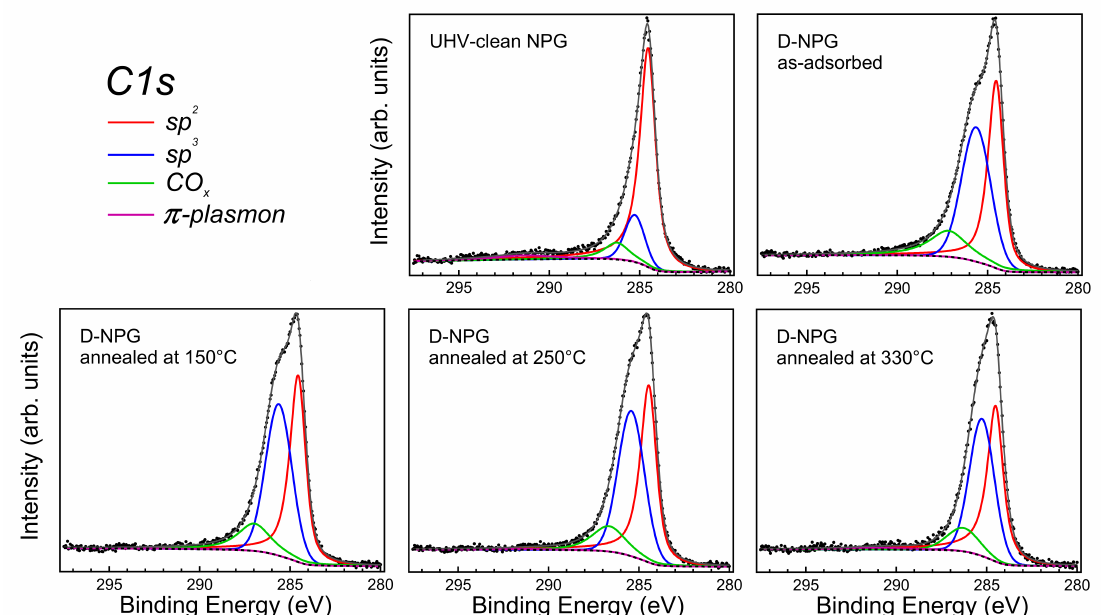
Figure 5. C 1s core level XPS spectra of UHV-clean NPG, as-adsorbed D-NPG and D-NPG after annealing at 150, 250 and 330 ◦ C: experimental data (black dots), sp 2 fitting components (red lines), sp 3 components (blue lines), CO x components (green lines), π - plasmon excitation (pink lines), Shirley background (black dashed lines) and fitting sum curve (gray